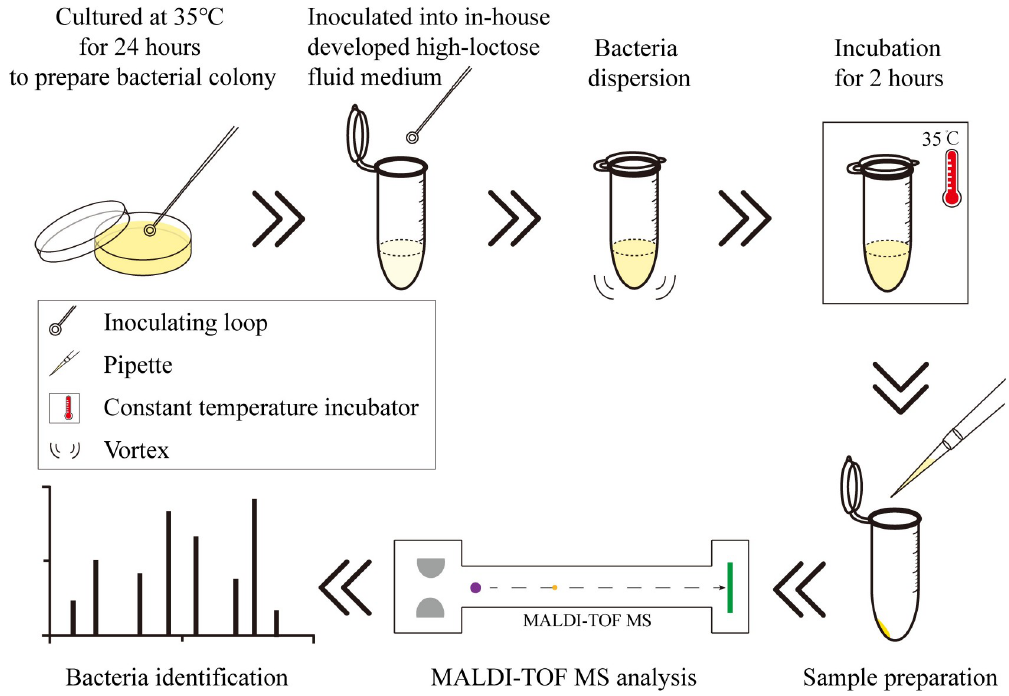
Fig 1. Procedures of the short-term culture approach. The procedures for the short-term culture using the in-house developed high-lactose fluid medium for the differentiation of the E . coli and Shigella species.